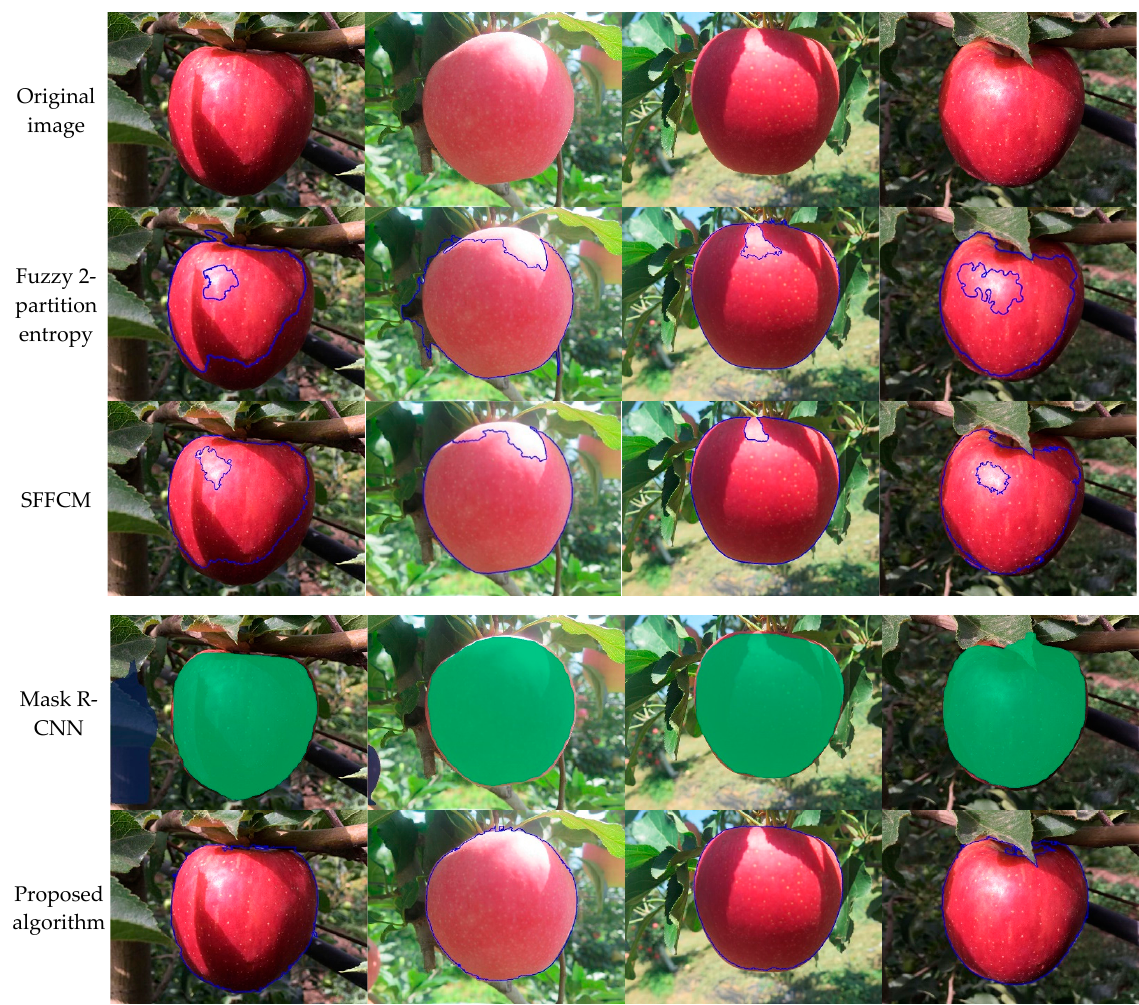
Figure 6. Experimental comparison of different methods: fuzzy 2-partition entropy, SFFCM, mask R-CNN, and the proposed algorithm. Table 1. Average Result Based on